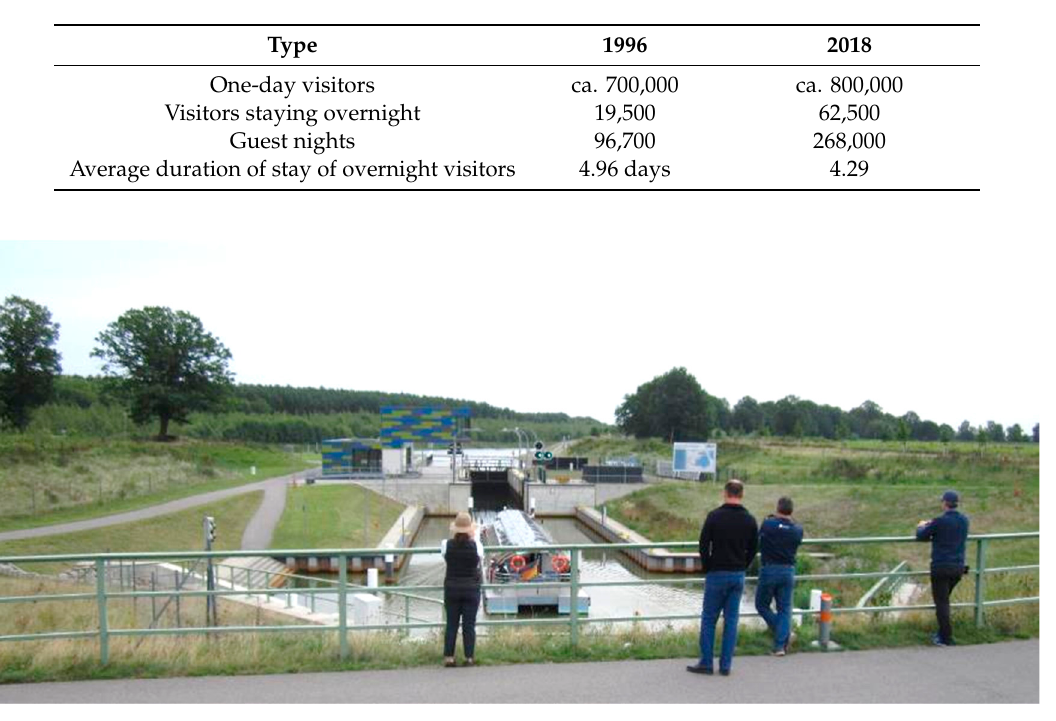
Figure 4. An excursion boat entering the water gate between Lake Senftenberg and Lake Geierswald (lakes 4 and 7 in Figure 7).